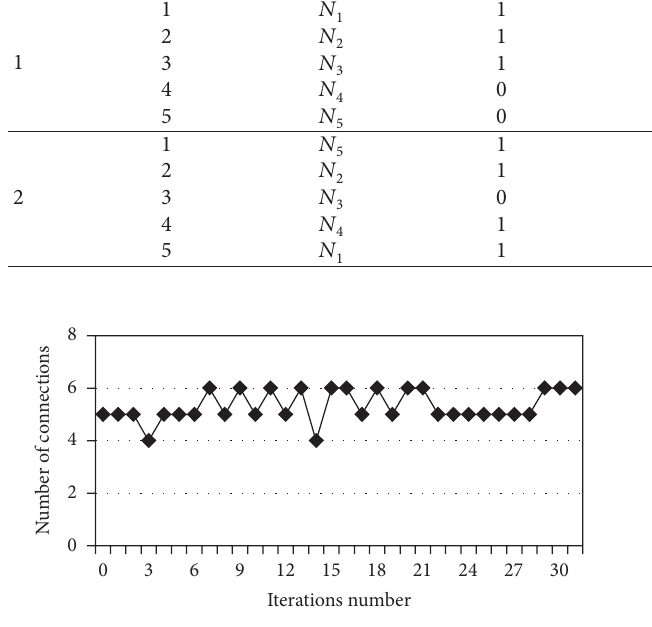
Figure 3: Number of connections at all iterations for 𝑝 = 4 .